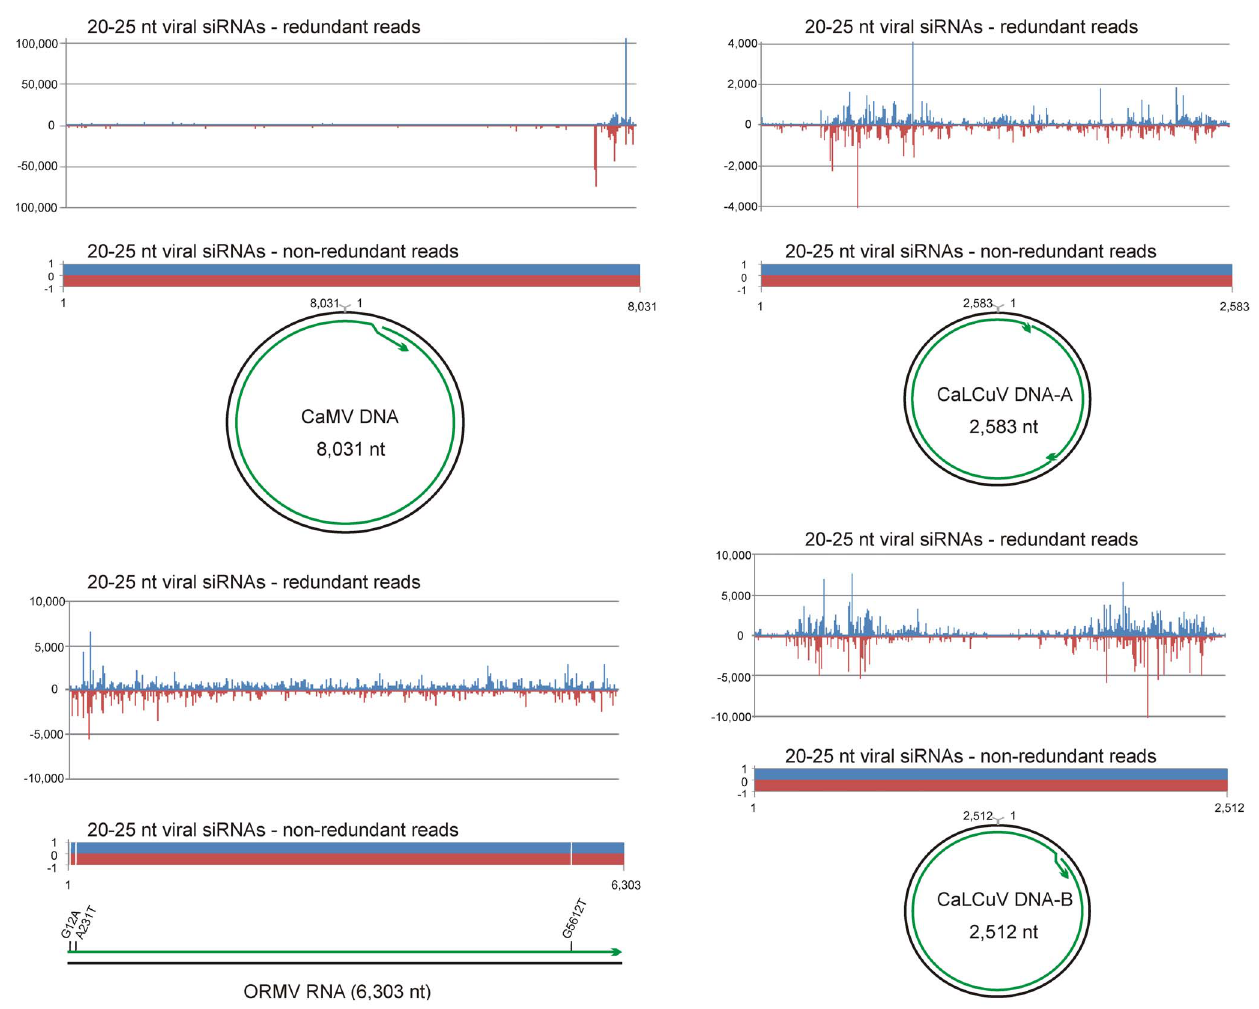
Figure 1. Maps of viral siRNAs and their contigs. The graphs plot the number of 20–25 nt viral siRNA reads (redundant and non-redundant) at each nucleotide position of the genomes of CaMV, ORMV and CaLCuV (DNA-A and DNA-B); Bars above the axis represent sense reads starting at respective positions; those below the antisense reads ending at respective positions. Circular DNA genomes of CaMV and CaLCuV and linear RNA genome of ORMV are shown below the graphs, with the siRNA contigs covering the genomes depicted as green lines with arrowheads. Mismatches between the ORMV contig and the reference genome are indicated.